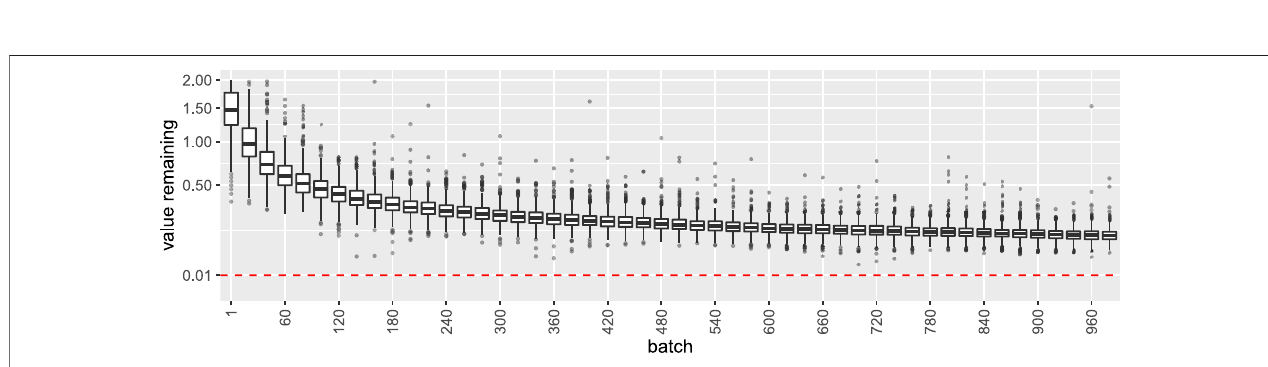
Frontiers in Arti fi cial Intelligence |